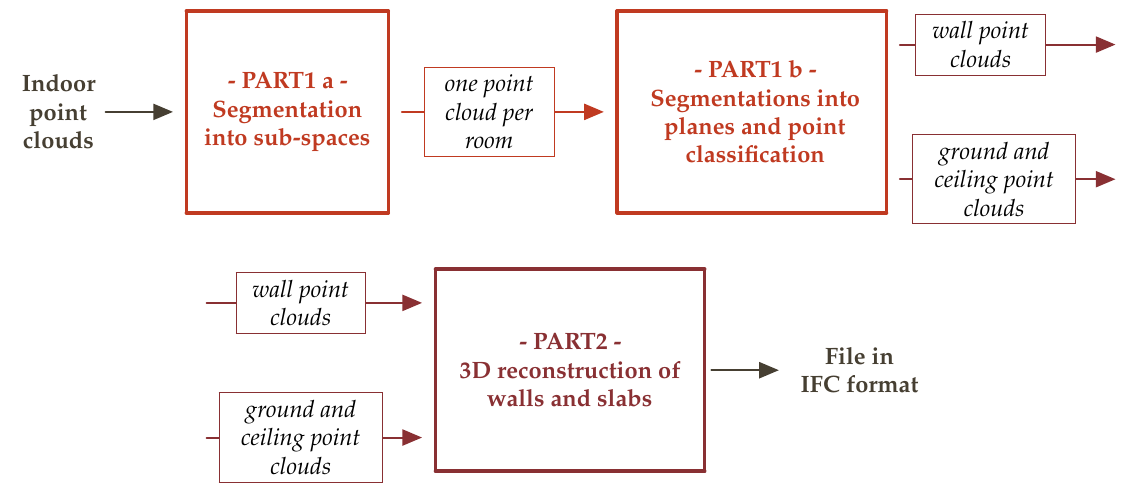
Figure 1. Overview of the developed approach.